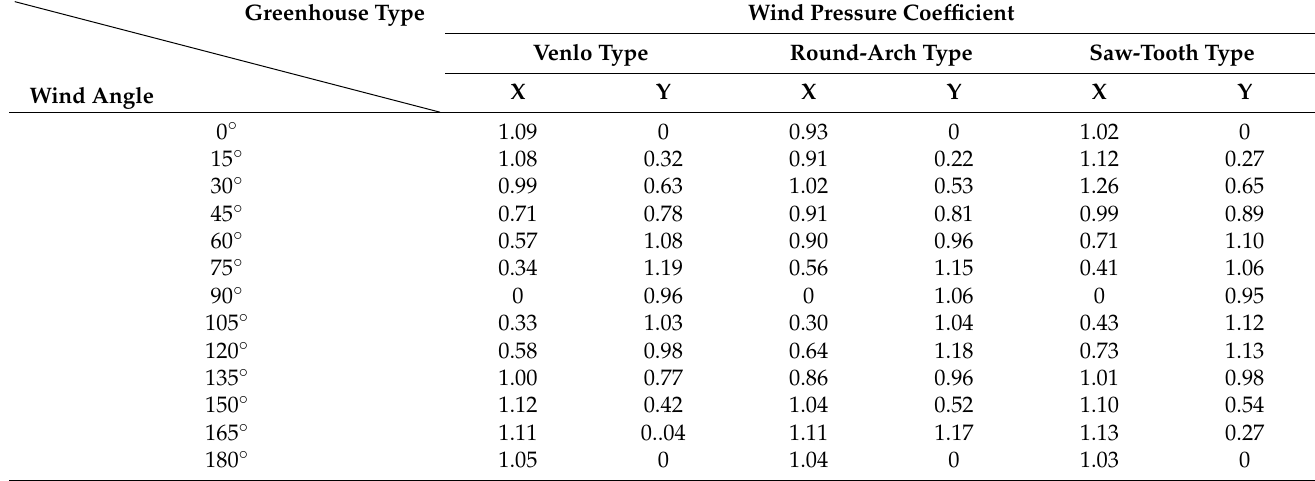
Table 8. Average wind pressure coefficients for the respective greenhouse in the X/Y direction at different wind